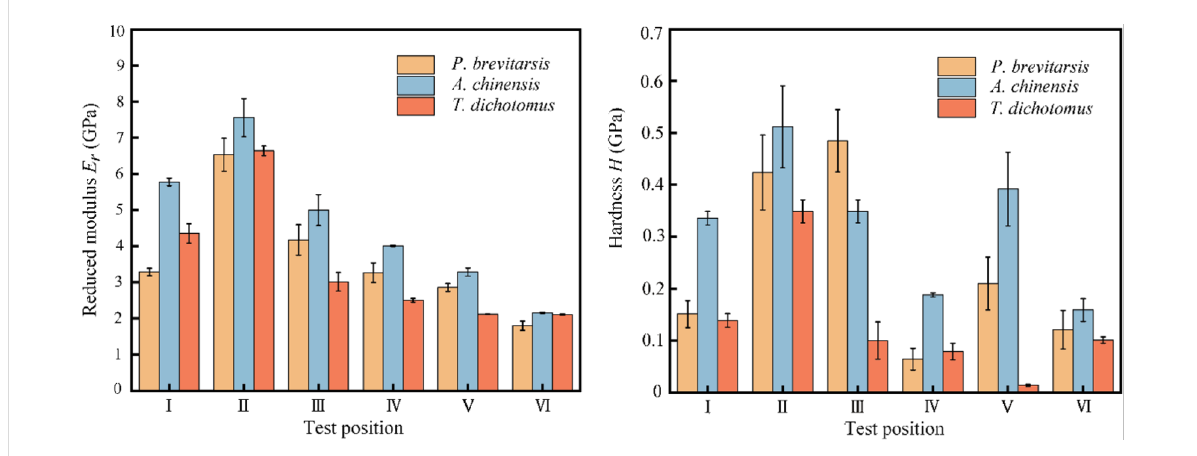
Figure 4: Nanomechanical test results of the anterior of the costal (I), the end of the costal (II), media posterior (III), cubitus anterior (IV), anal poste- rior (V), and wing membrane (VI).